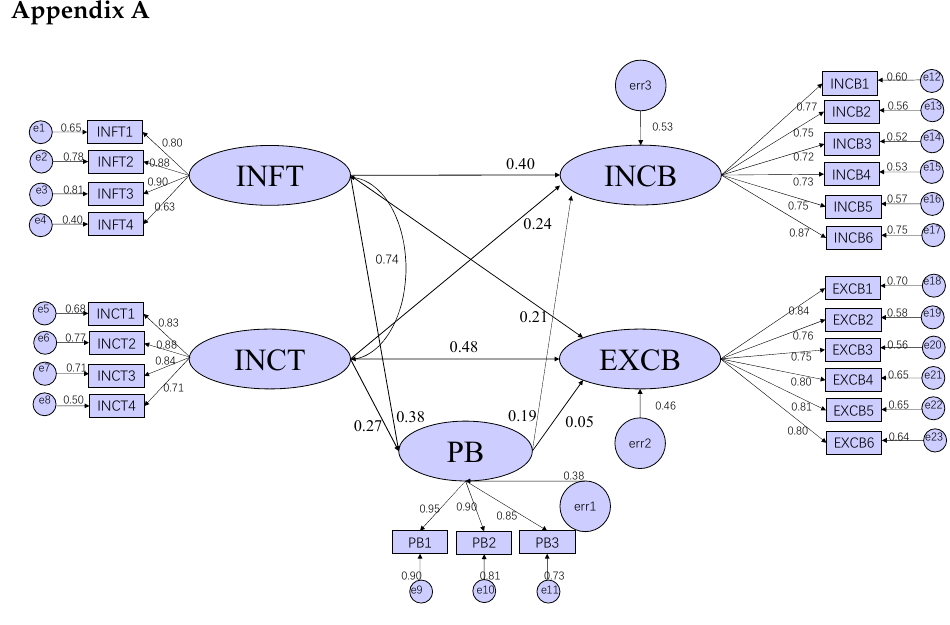
Figure A1. Standardized estimate of the SEM model.